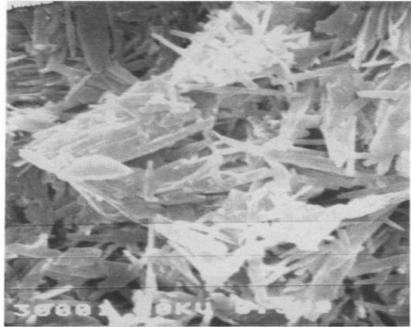
Figure 11. Sandstone core from Tuscaloosa reservoir in post-flow conditions (note—this figure points to the reasons for formation damage)